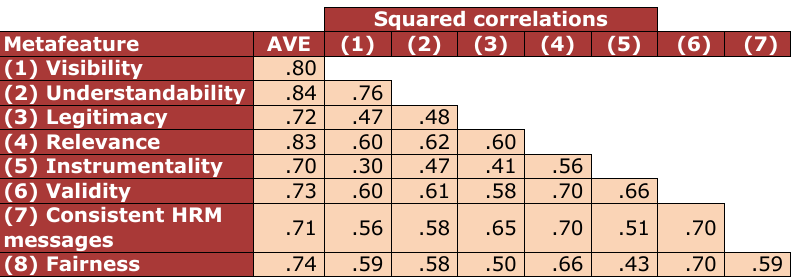
Table 4. Discriminant validity of the HRM SQ model: Comparison of the AVE with the squared correlation of the